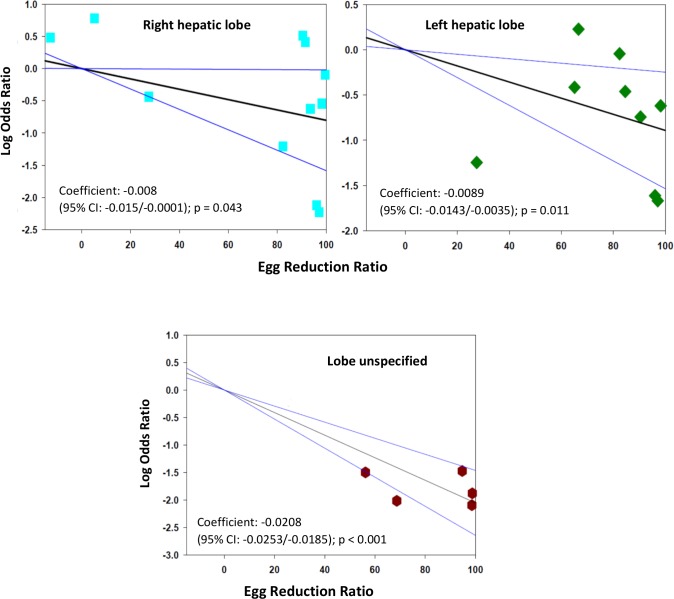
Log odds ratio for post-treatment hepatomegaly, according to egg reduction rates achieved, by hepatic lobe.The figure panels show the log10 of the post-treatment/pre-treatment odds ratio of morbidity, according to each study’s treatment mediated egg reduction rate (ERR), as related to hepatomegaly in the right lobe (upper left panel), n = 11, in the left lobe (upper right panel), n = 9, or where the lobe was not specified (lower panel), n = 5. N.B. the very low ERRs (< 0 to 20%) reflect observed post-treatment intensity outcomes seen among placebo-treated subgroups.